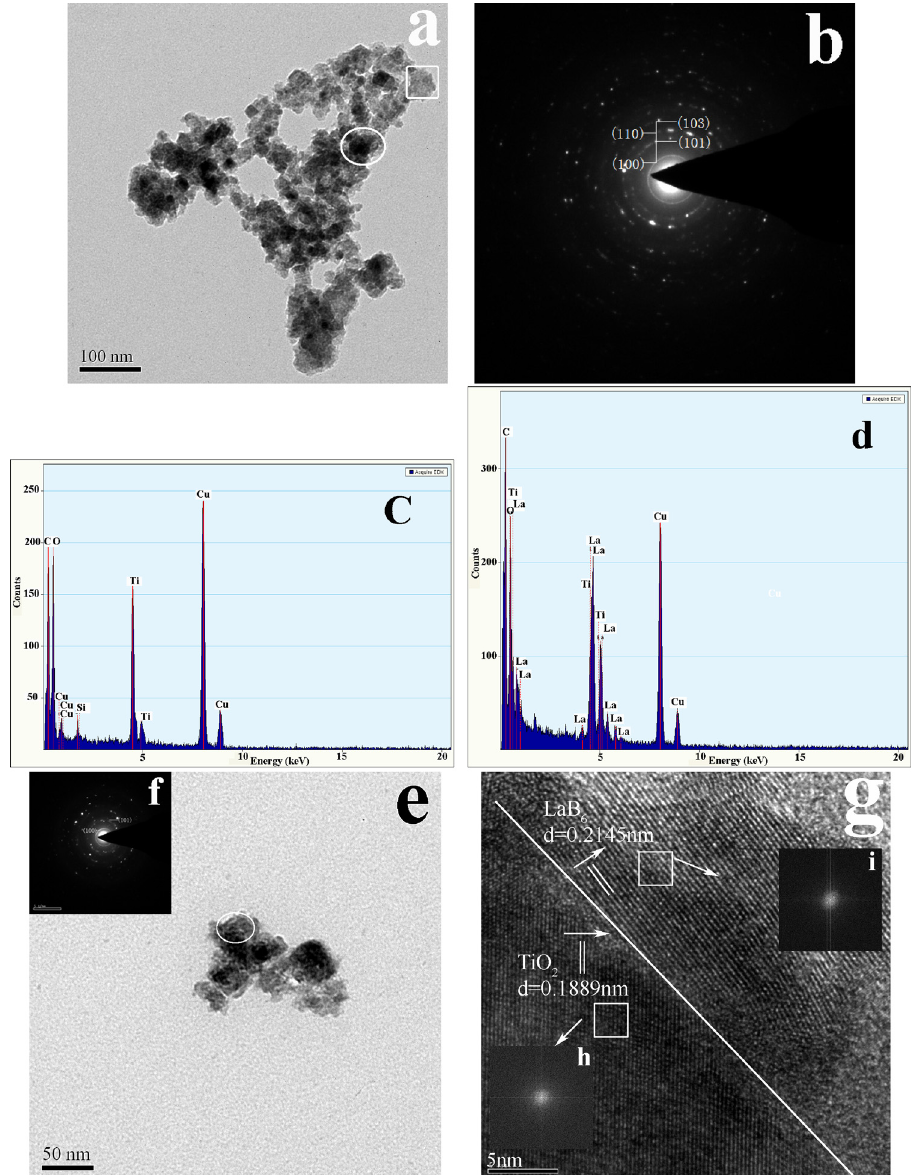
Figure 3: ( a ) TEM image and ( b ) electron di ff ractive spots of LaB 6 @TiO 2 NPs. EDX results of ( c ) the square spot and ( d ) the circular spot in ( a ) . ( e ) TEM image and ( f ) electron di ff ractive spots of a LaB of the core and the shell,